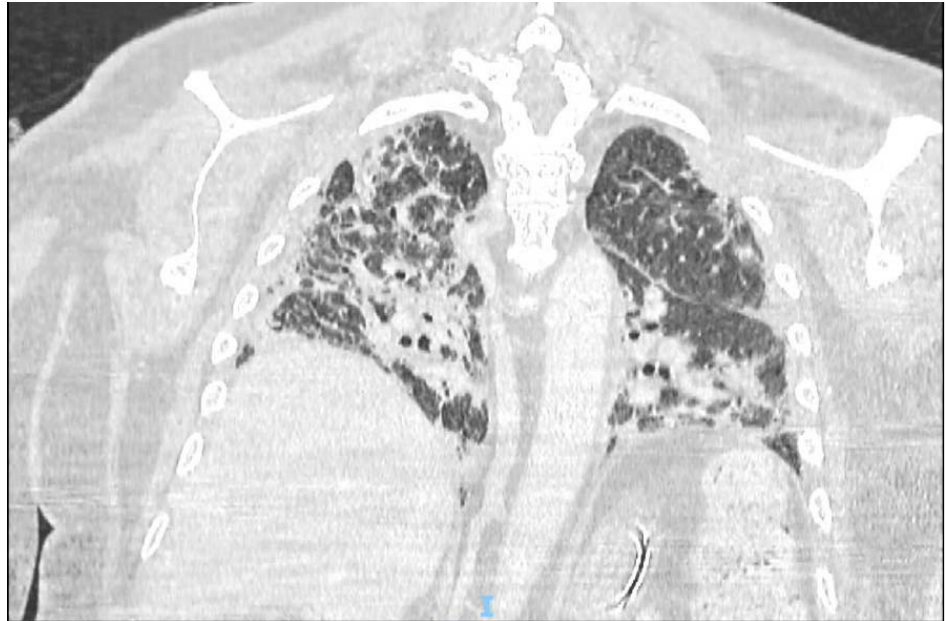
Figure 1. Aspergillus niger co-infection in COVID-19 ARDS. Bronchoalveolar lavage, soon after endotracheal intubation, showed galactomannan positivity (OI = 5) and direct identification of the mold. The patient already received IL-6 inhibitors and was ongoing dexamethasone. The clinical picture healed after four weeks of voriconazole.